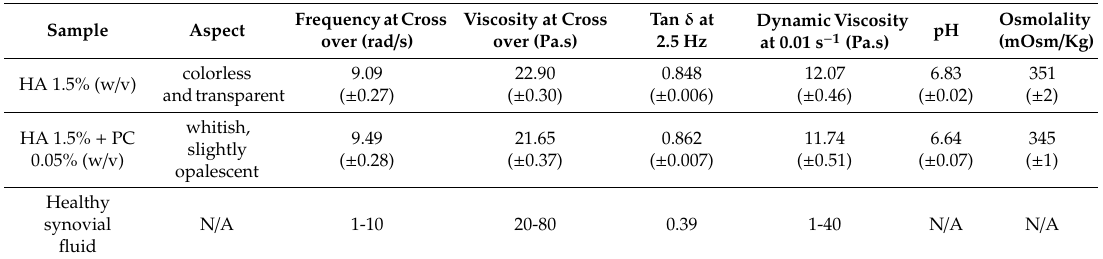
Table 6. Aspect and functional parameters of the optimized HA formulation with and without